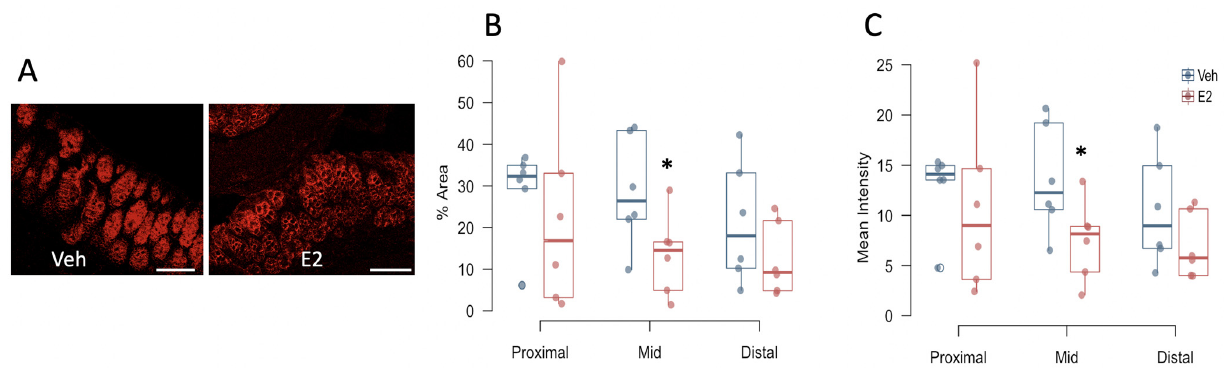
Figure 6. Estradiol decreases occludin immunoreactivity in colonic epithelium in female mice fed HFD. Colon tissues were collected on day 22 (15 days after start of HFD). Occludin immunolabeling in representative mid-colon sections from a Veh ( left ) and an E2-treated ( right ) mouse ( A ), Percent area ( B ) and mean intensity ( C ) of occludin immunoreactivity in the three subdivisions of the colon. Scale bar = 100 µm. * indicates differences between E2 and Veh mice (n = 6/group) ( p < 0.05, t -test).